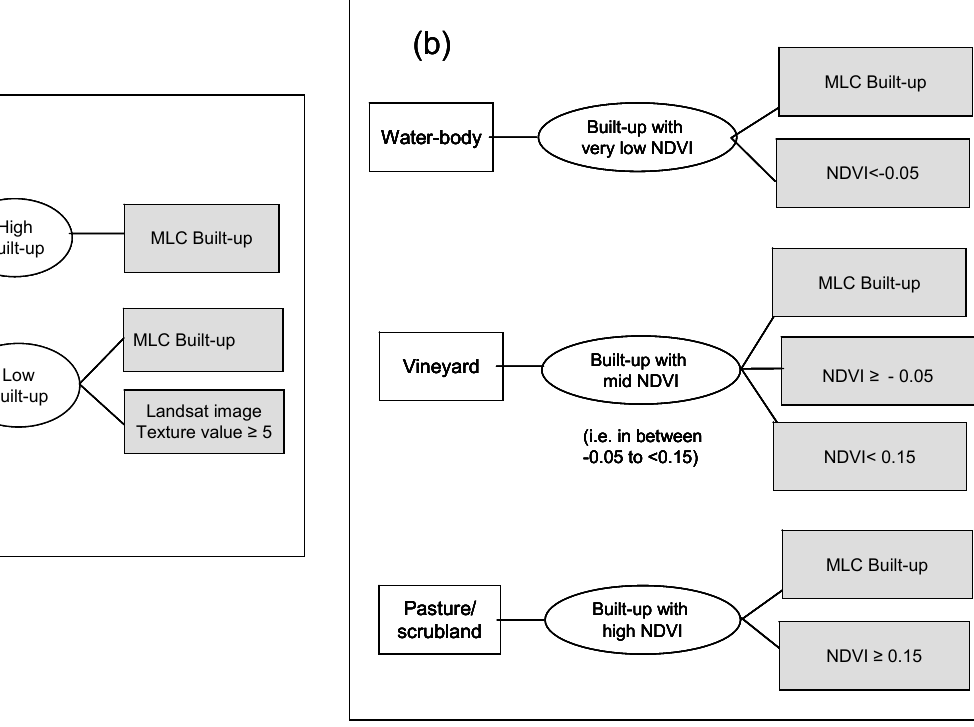
Figure 2. Hypothesis testing framework for Built-up correction. In both (a) and (b): the left white box is the hypothesis being tested, the ellipses represent the conjunctive decision rules and right shaded boxes represent the variables used. (a) Built-up of MLC classification with the Landsat textural value above some critical level only is retained as Built-up of PCC classification in case of low Built-up areas. (b) Built-up of MLC classification which is not included as Built-up of PCC classification are reclassified to other LULC categories based on critical levels of NDVI